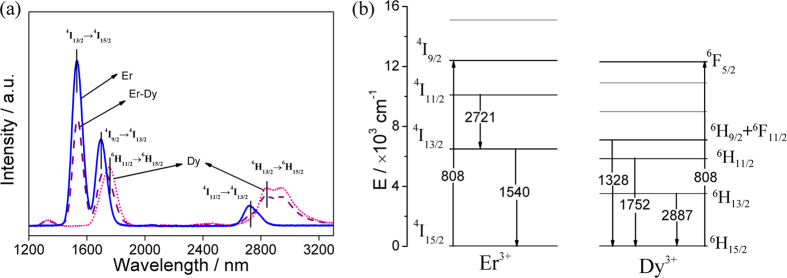
(a) The IR fluorescence spectra and (b) energy transfer scheme of 65GeS2–25In2S3–10CsI glasses doped with Er3+-, Dy3+-, and Er3+-Dy3+, respectively.